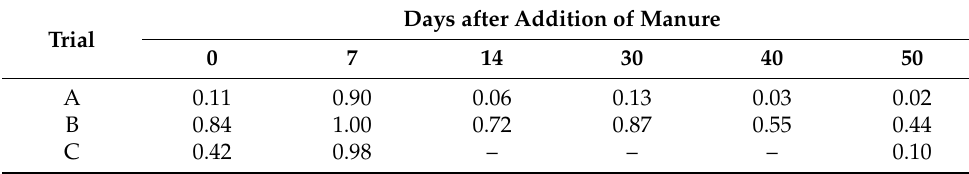
Table 4. Predicted probability of detecting Salmonella spp. in soil amended with inoculated poul- try litter.